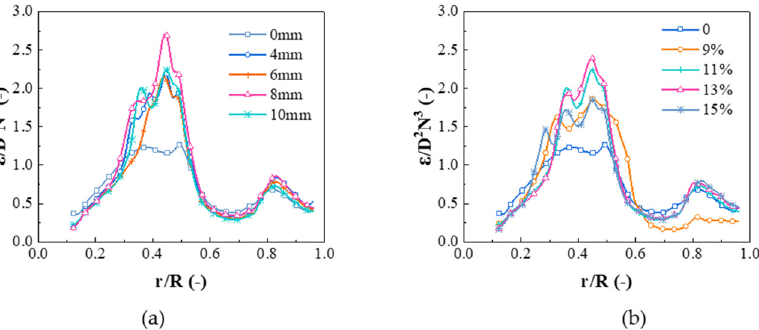
Figure 14. Influence of aperture parameters on local radial turbulent kinetic energy dissipation rate profiles. ( a ) Influence of aperture diameter, ( b ) influence of aperture ratio.